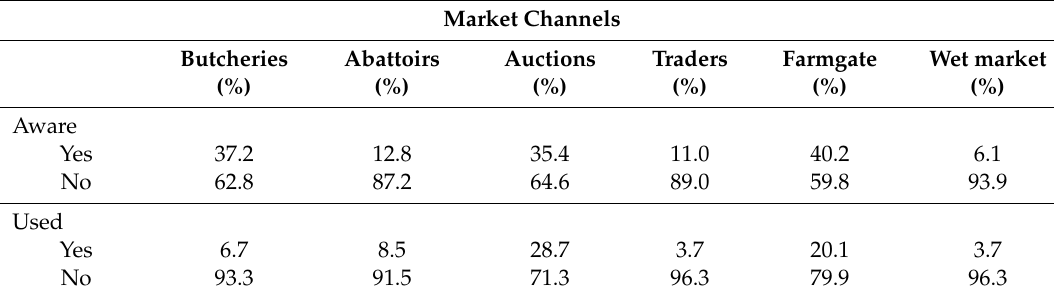
Table 4. Market channels